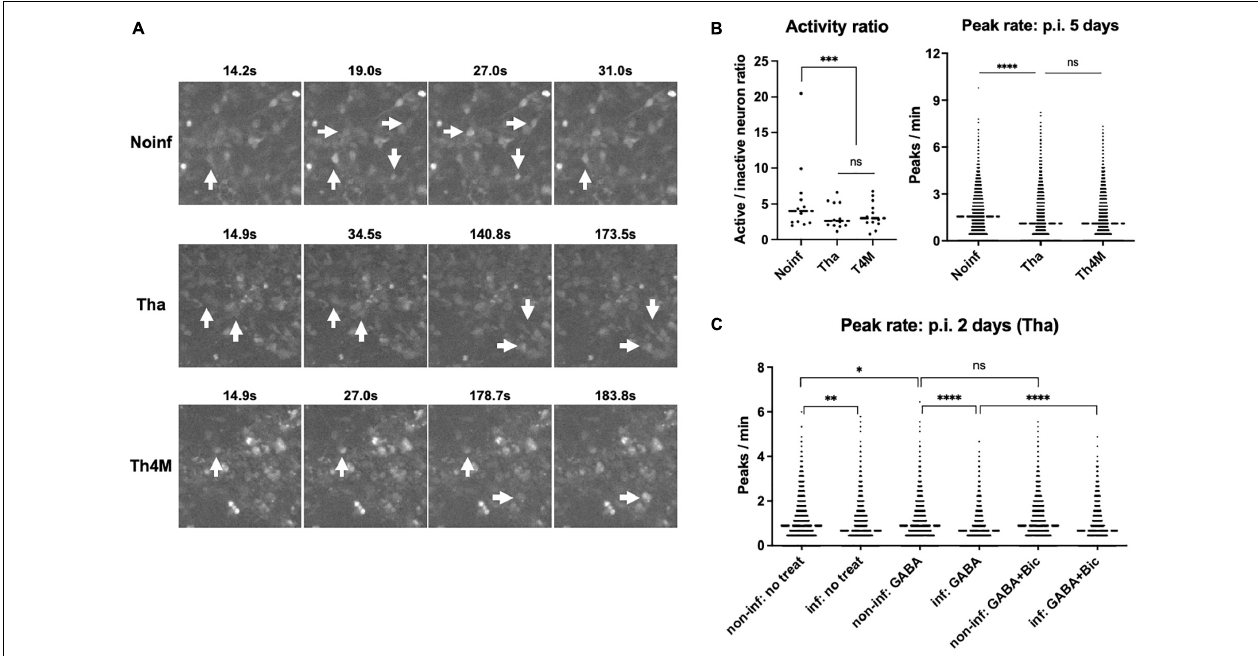
FIGURE 5 | Decreased spontaneous activity in RABV-infected neurons. The hiPSC-derived NPCs were differentiated into neurons for 2 weeks and then infected with Tha/Th4M virus for 5 days at MOI 3. (A) Examples of active neurons visualized with Fluo-4 staining. Size of the images represents 1.6% of field of view (150 × 150 pixels out of 1360 × 1024). Individual somas marked with white arrows show the intensity changes over time (active neurons). Video format of the same images is provided in Supplementary Figure 6 . (B) The active/inactive neuron ratios were counted from 12 imaging sessions of non-infected/infected conditions, and are presented as individual value graph on the left panel. The neurons that had more than one calcium peak detected during the imaging were considered as active. Bartlett’s test evaluated the significant difference between the conditions. On the right panel, the graph represents frequencies of calcium peaks collected from over 5,000 individual somas at each condition. Student’s t -test was performed to show the statistically significant difference between conditions. (C) H9-NSC-differentiated neurons and the decreased spontaneous activity on 2 days post-infection. The H9-NSCs were differentiated into neurons for 4 weeks and then infected with Tha virus for 2 days at MOI 1. The frequencies of calcium peaks were calculated from over 1,500 individual somas and presented in the graph. The non-infected and infected conditions show a statistical difference in Student’s t -test, while the non-infected and infected conditions with GABA treatment (two graphs in the middle) presented stronger difference. GABA A receptor antagonist Bicuculline (Bic) partially reversed the effect of GABA and Tha infection, as shown in comparison of GABA/GABA + Bic treatment in infected conditions. Asterisks represent statistical significance; ∗ for P -value < 0.05, ∗∗ for < 0.005, ∗∗∗ for < 0.0005, and ∗∗∗∗ for < 0.00005. GABA, Gamma-aminobutric